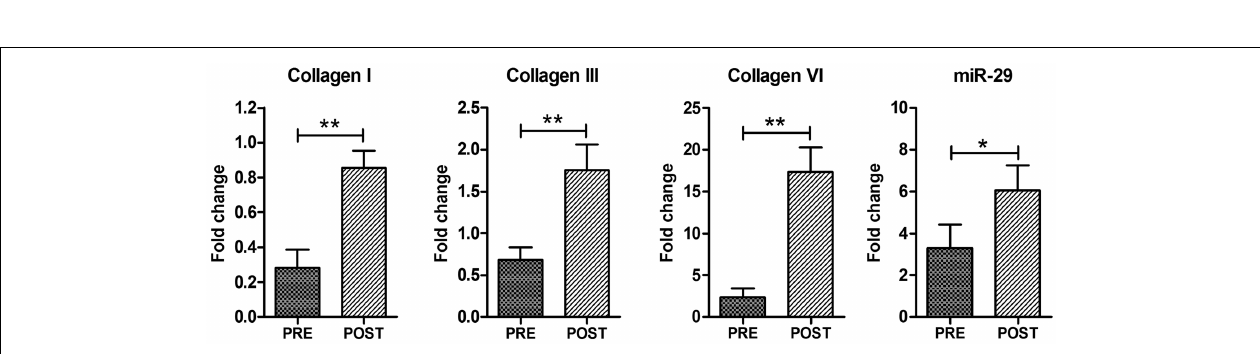
FIGURE 4 | Electrical stimulation promotes ECM remodeling . Real time PCR analysis for Collagen I, Collagen III, CollagenVI, and miR-29. Data are represented as average ± SEM. n = 16. * p < 0.05; *** p <